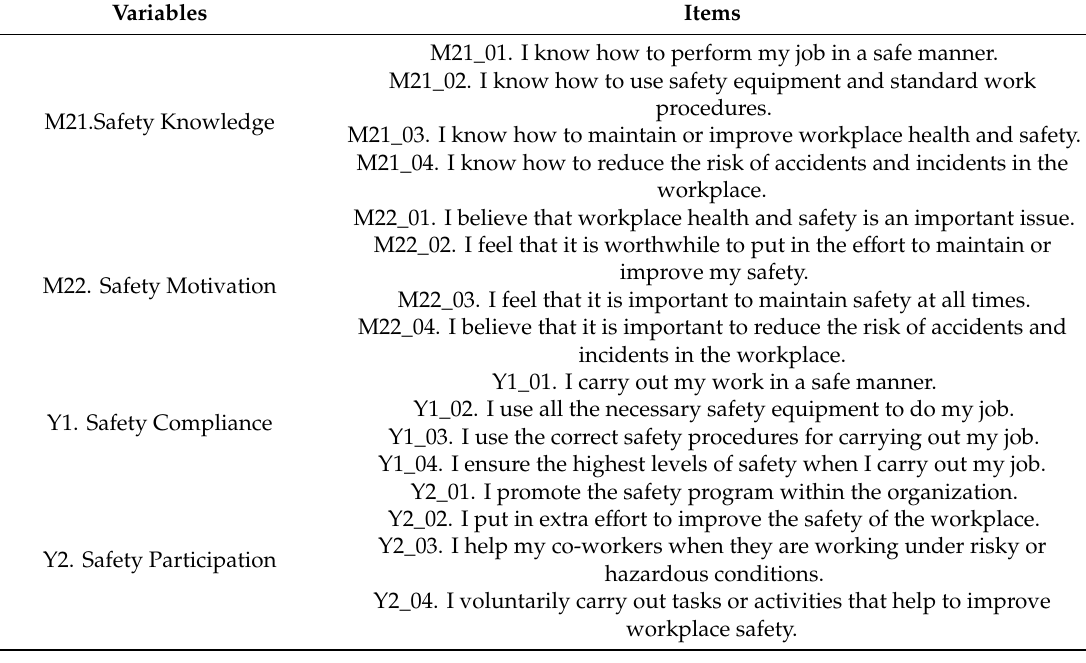
Table 3. Questionnaire items on safety motivation, knowledge, and